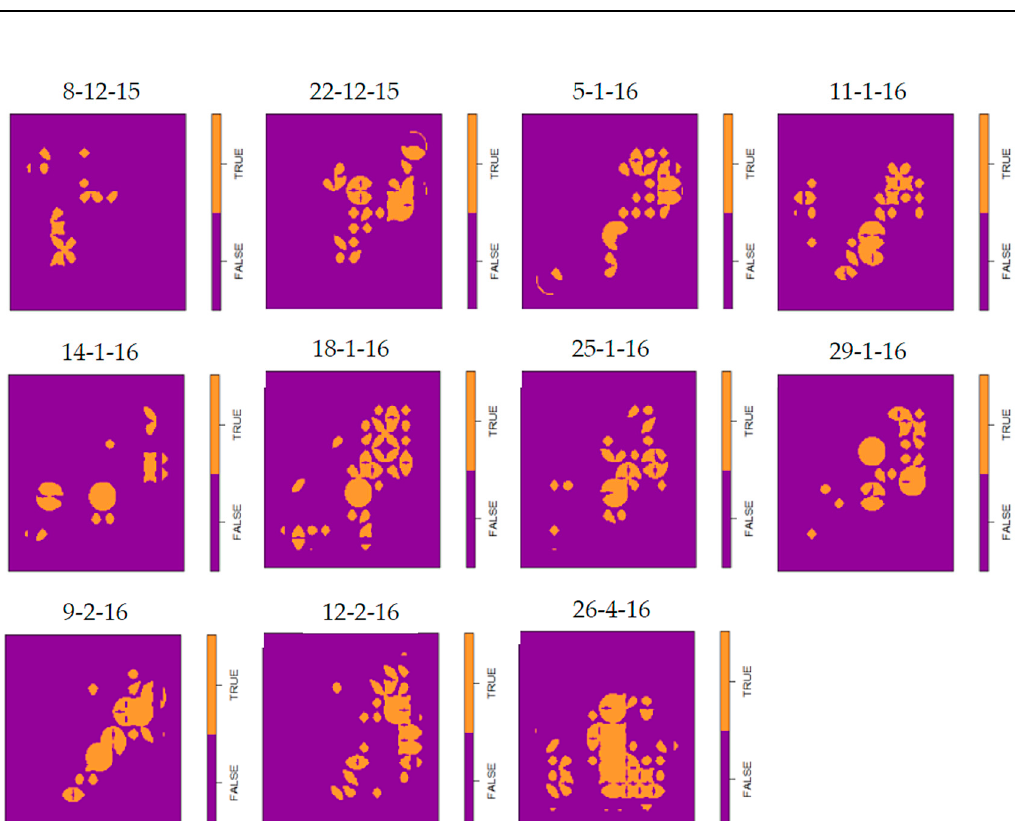
Figure 4. Visualized grid map showing the location of domains of higher slug density identified by hotspot analysis of data collected from a 10 × 10 grid of refuge traps, set within a rectangular 1ha plot at the Shrops 2 field site between December 2015 and April 2016. Data for each of the 11 assessments made at this site were analyzed separately; grid squares colored in amber indicate the location of discrete domains with significantly ( p < 0.05) higher numbers of slugs than would be expected if a random distribution is assumed. Dates above each map indicate the day on which the assessment was made. For grid maps from all field sites used in the study see Figures S1–S22. The Shrops 2 field site was sampled in each of three consecutive growing cycles and for comparison equivalent grid maps for crops grown in the 2016/17 and 2017/18 cropping seasons are provided in Figures S6 and S18.